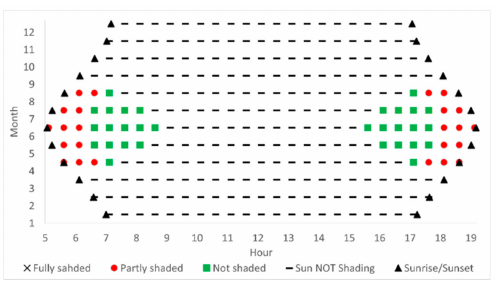
Figure 10. State of shading: south-facing surface, latitude 32 ◦ N, D = 20 m, H = 10 m, L = 40 m.